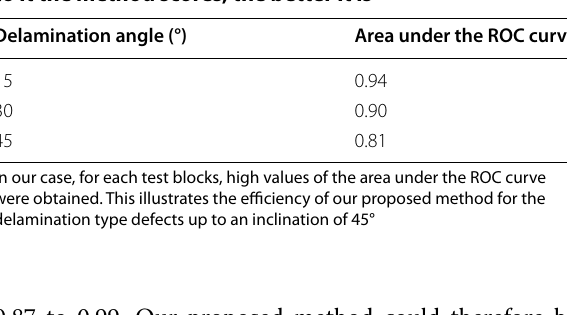
Table 1 Area under the ROC curve for each delamination type blocks: the maximun value obtainable is 1 and closer to it the method scores, the better it is